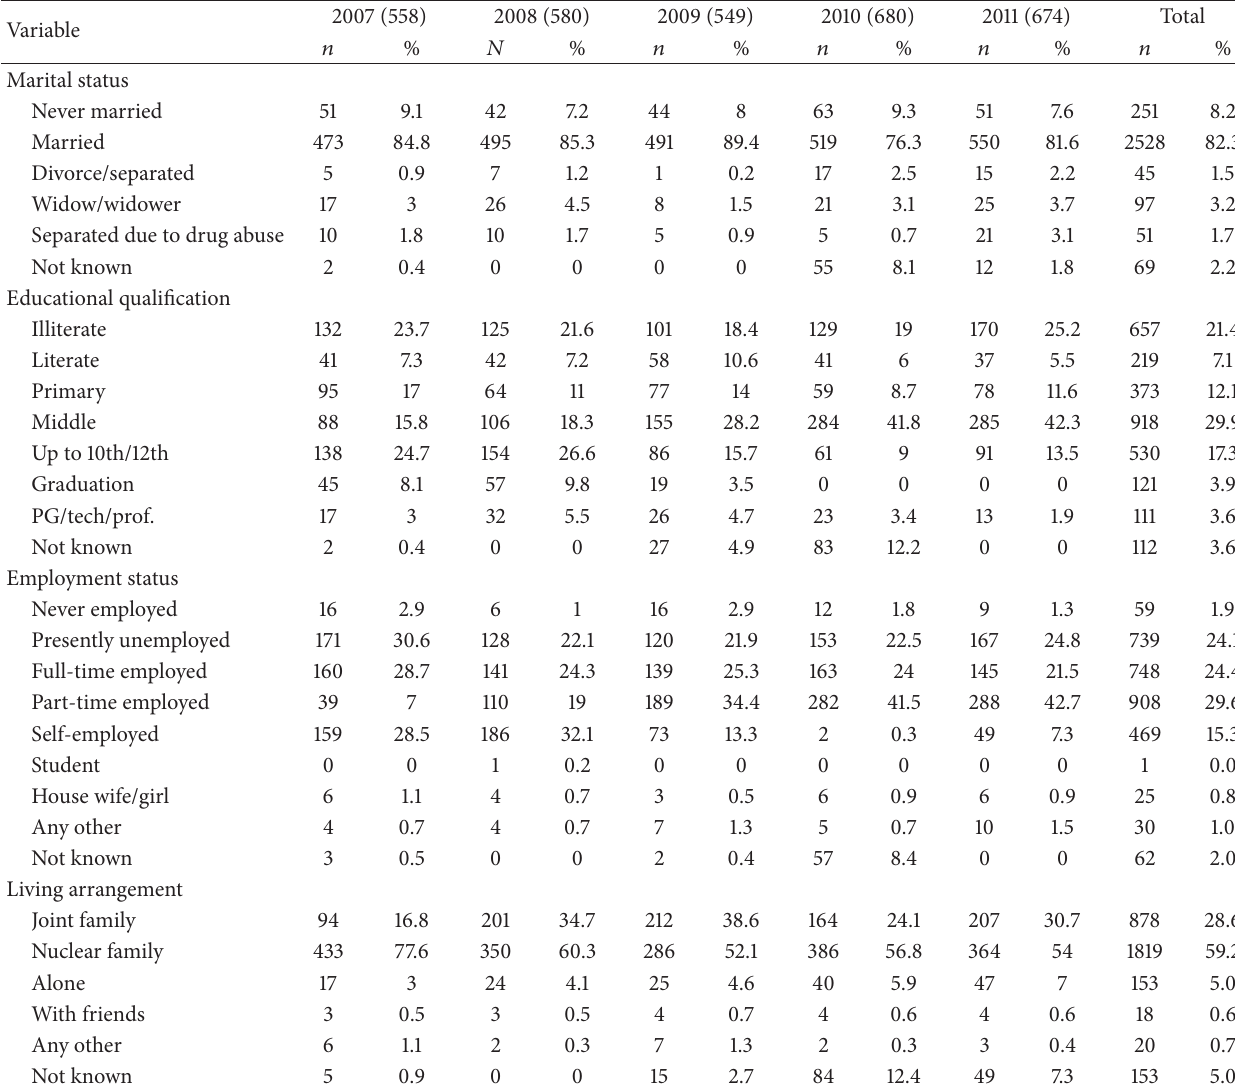
Table 1: Sociodemographic variables of the treatment seeking middle aged individuals over the 5-year period.